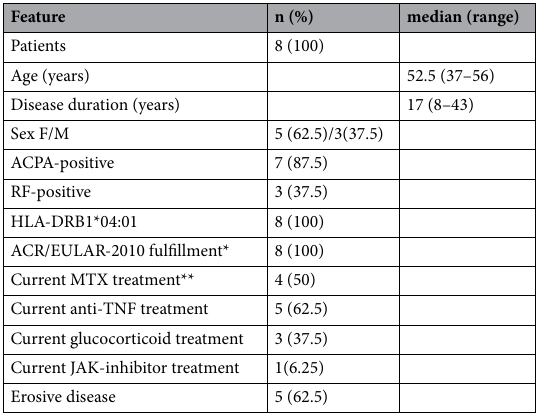
Table 1. Patient clinical characteristics. *One patient was initially diagnosed with JIA but was later re-diagnosed ACPA + RF + rheumatoid arthritis. **One patient did not have any active antirheumatic